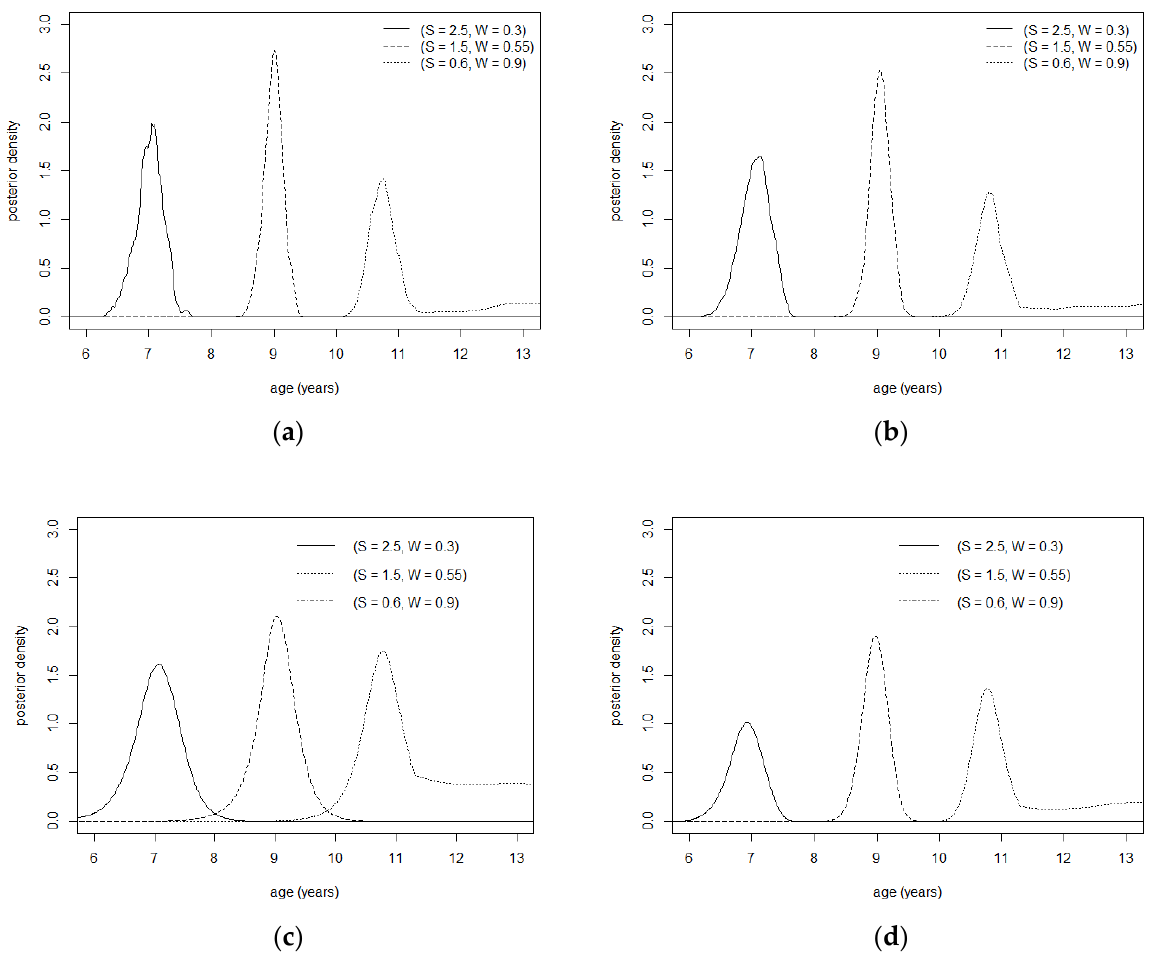
Figure 2. Posterior age distribution for given values of S and W with a Rotated Clayton (90°) model in the validation sample. ( a ) S and W normally distributed. ( b ) S and W asymmetric Laplace distributed. ( c ) S asymmetric Laplace distributed and W normally distributed. ( d ) S normally distributed and W asymmetric Laplace distributed.